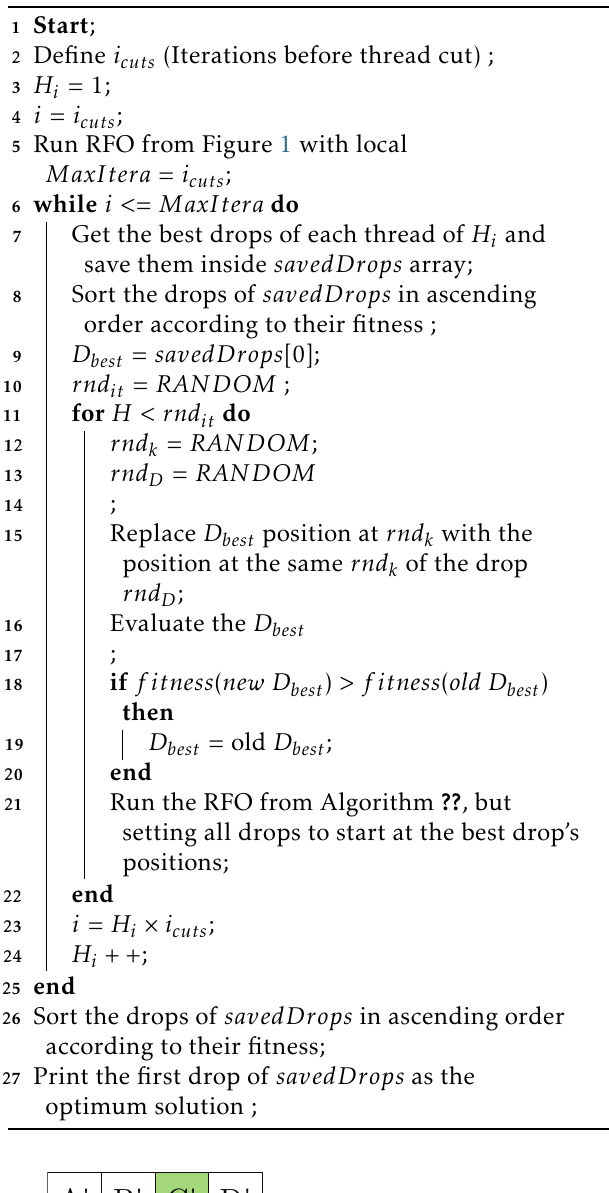
Algorithm 2: Genetic Algorithm Pseudocode